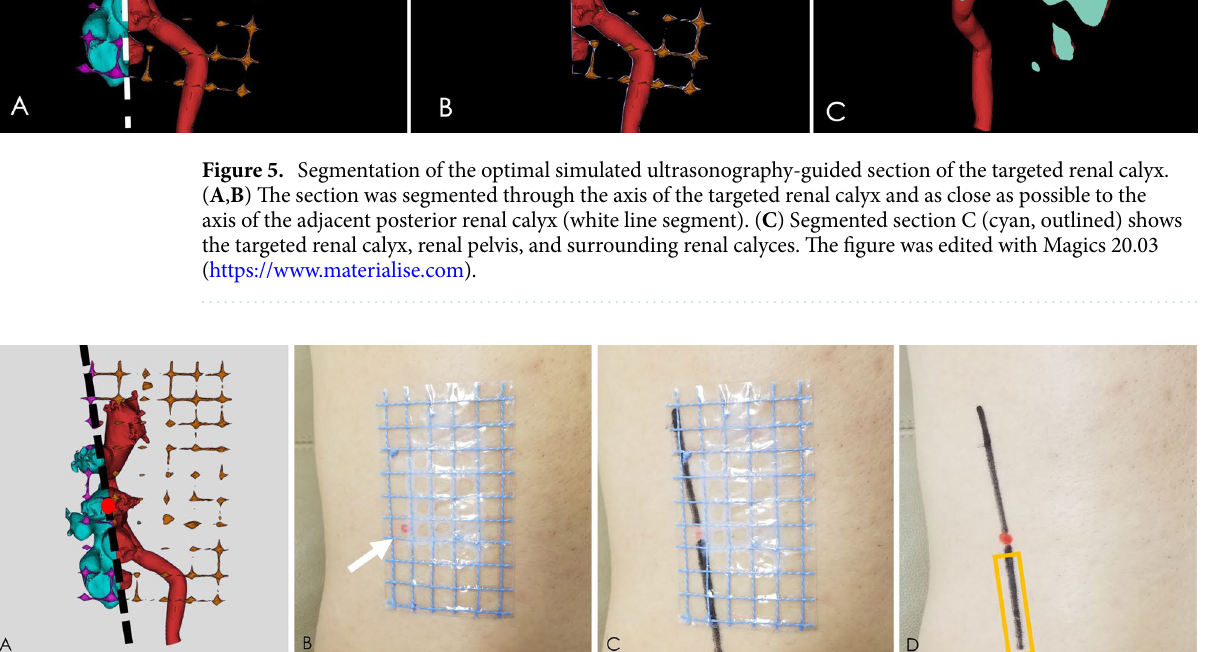
Figure 6. Location of the skin puncture point and ultrasonic probe. ( A ) Skin puncture point (red dot) and tangent of section C are located on the grid patch (black line segment). ( B ) Point of skin puncture (red spot indicated by the white arrow) was located on the skin of the patient using the grid surface patch. ( C ) Tangent of section C, which was restored on the skin of the patient using a grid surface patch (black line segment). ( D ) Tangent (black segment in the golden box) of section C on the grid surface patch, which is where the ultrasonic probe was